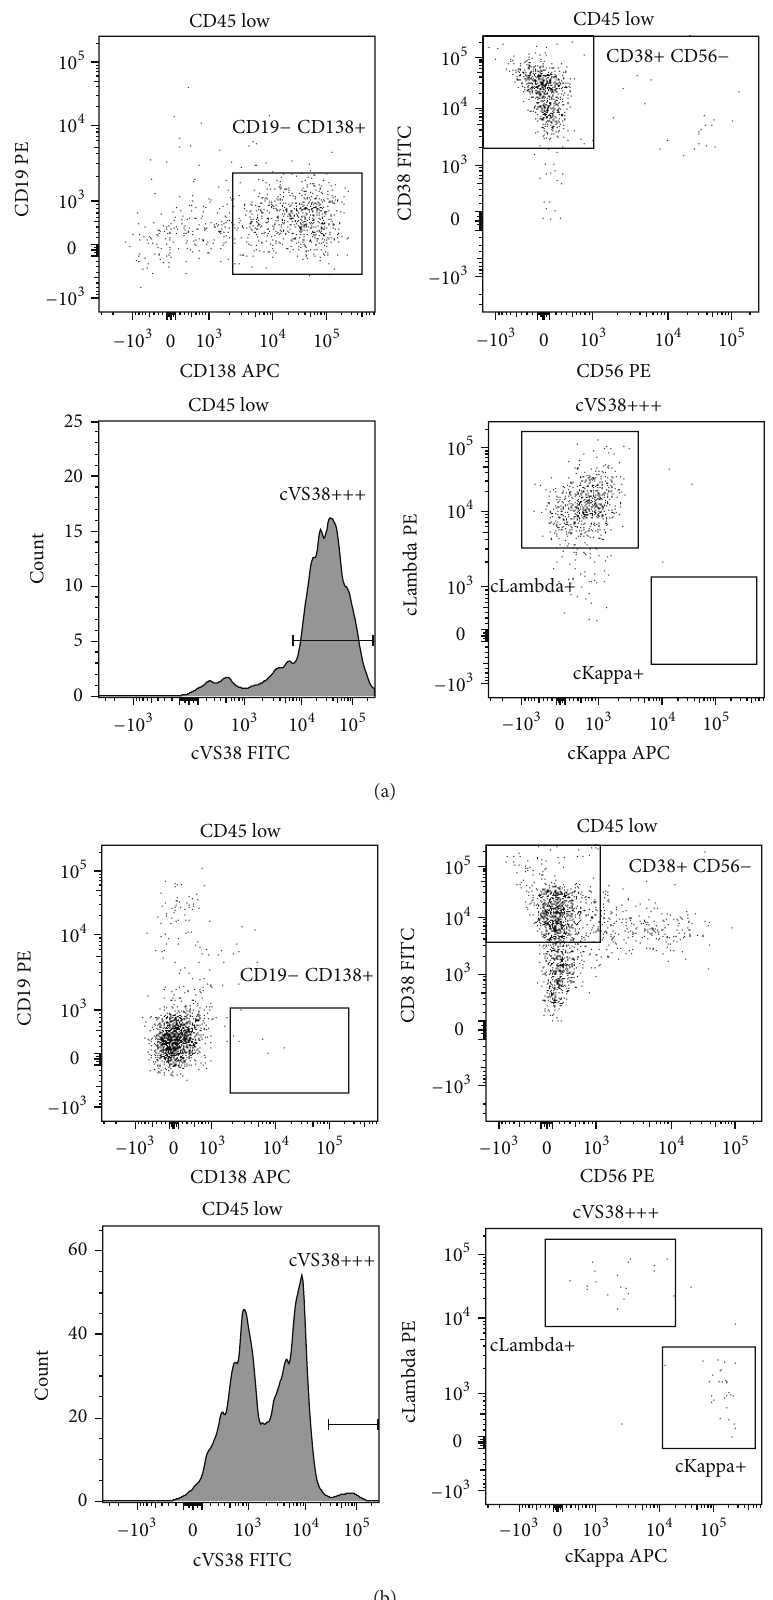
Figure 2: Flow cytometric data at second relapse, February 2012, reveal isolated CNS relapse. (a) CSF with clonal plasma cells with the same phenotype as diagnosis (CD138+, CD38+, and CD56 − ). (b) Bone marrow aspirate without clonal plasma